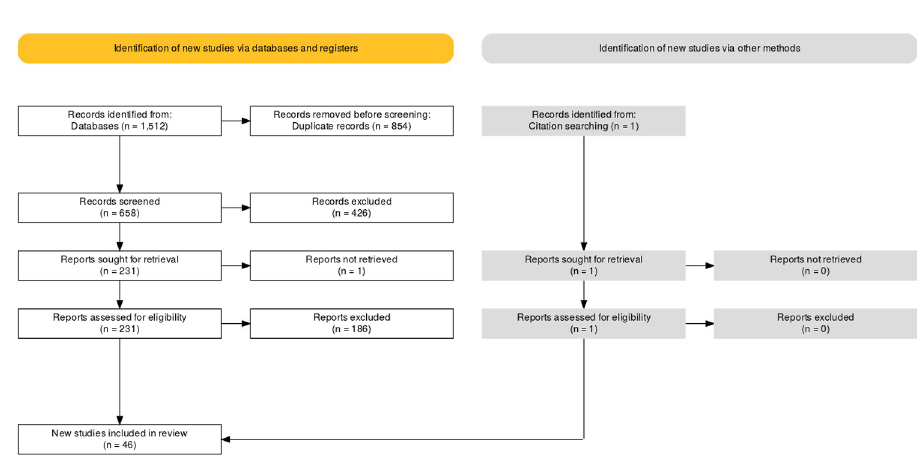
Fig 1. PRISMA flow